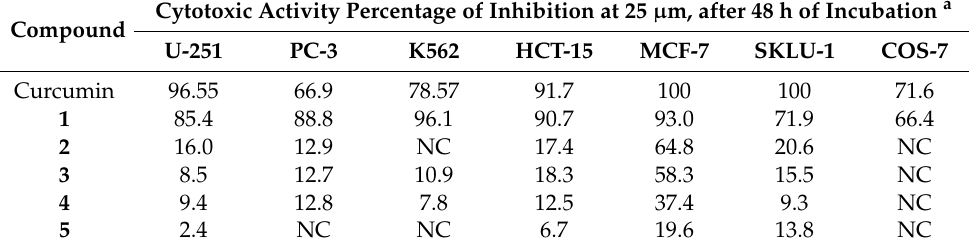
Table 1. Biological screening of curcumin derivatives 1 – 5 compared with curcumin.